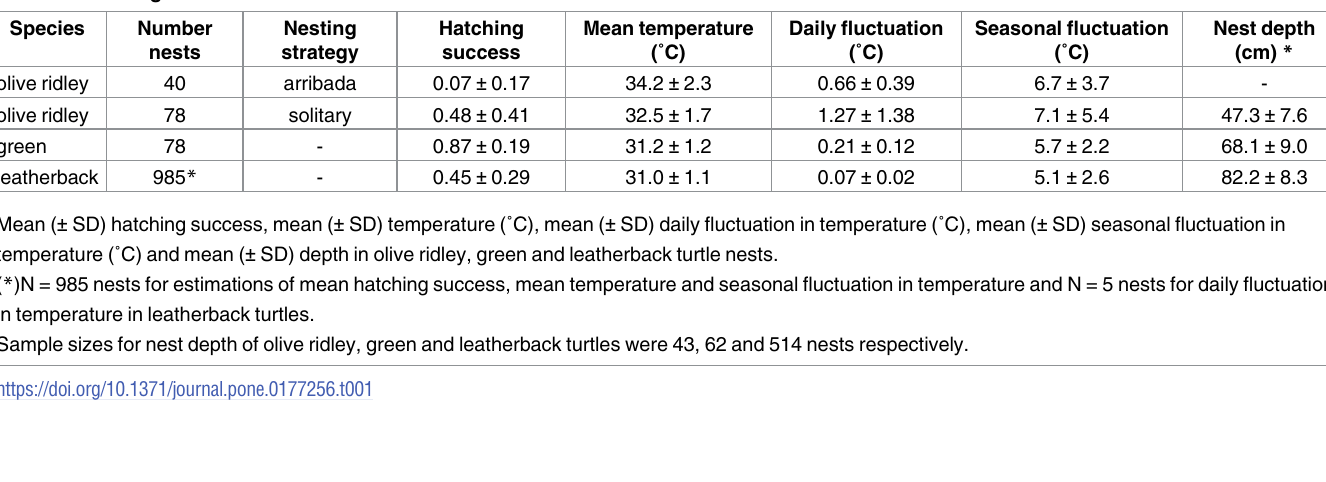
Table 1. Hatching success and thermal conditions of sea turtle nests in North Pacific Costa Rica.